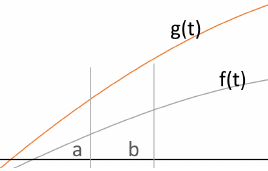
Figure 3. Functional limit.